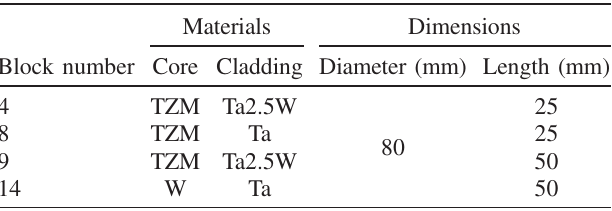
TABLE IV. Materials and dimensions of the four target prototype blocks that were selected to be